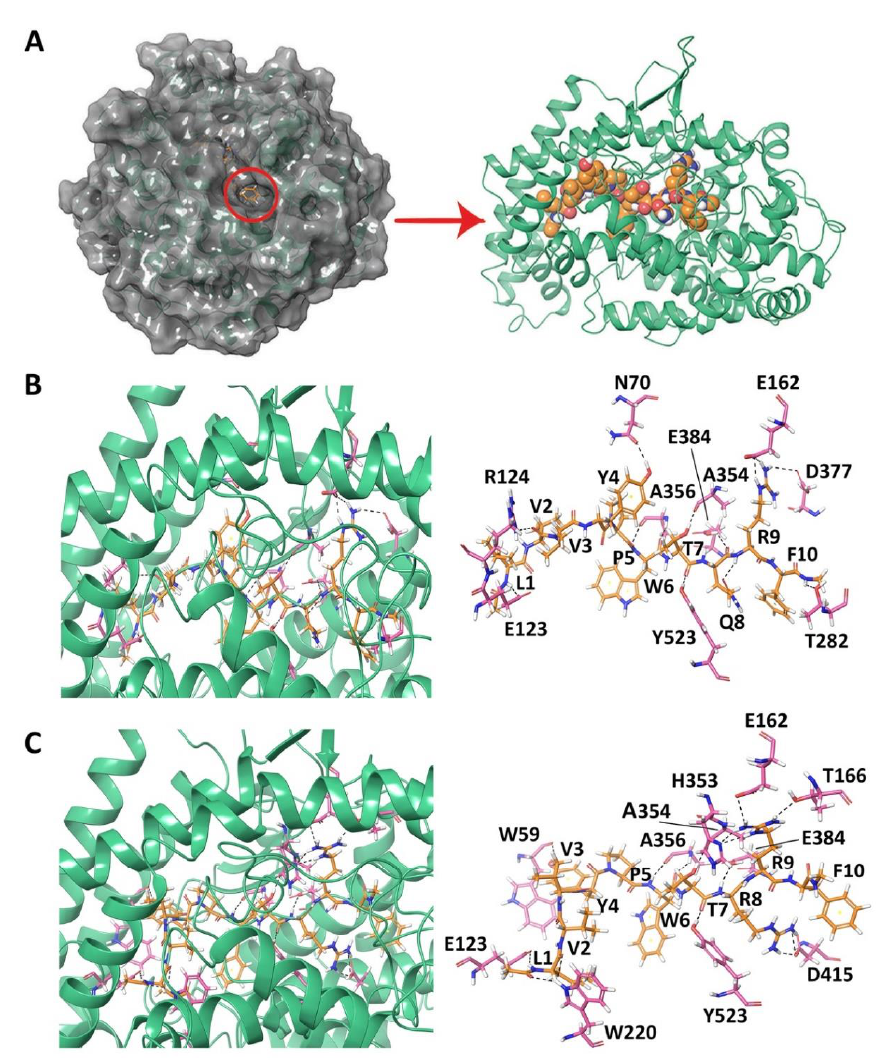
Figure 1. ( A ) Angiotensin-I converting enzyme with a peptide bound in the active site. ( B ) Docked pose and hydrogen bond interactions of LVVYPWTQRF with ACE. ( C ) Docked pose and hydrogen bond interactions of LVVYPWTRRF with ACE. The ACE protein is shown in green cartoon representation and its interacting residues are shown in pink stick representation; the docked ligand is represented as orange sticks, and hydrogen bonds are shown as black dashed lines